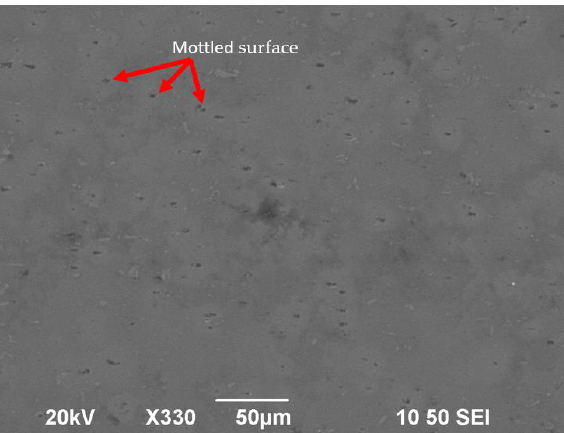
Figure 11. Mottled surface after lapping process (rotational speed 1000 rpm, time 15 min, slurry: SiO 2 ).